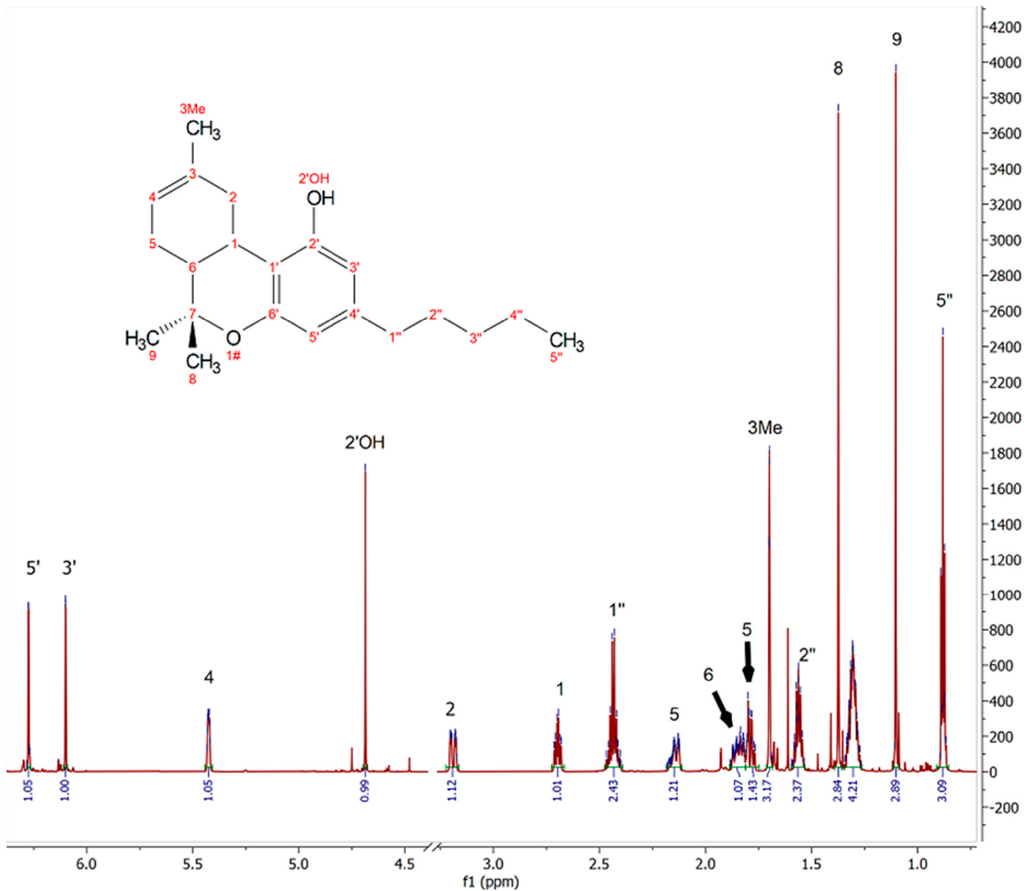
Figure 2. 800 MHz 1 H NMR spectrum of selected sample 3 (empty region from 3.35 ppm to 4.55 ppm omitted) (800 MHz, CDCl 3 ) δ 6.27 (d, J = 1.6 Hz, 1H), 6.10 (d, J = 1.6 Hz, 1H), 5.49 – 5.37 (m, 1H), 4.67 (s, 1H), 3.19 (ddd, J = 17.6, 5.0, 1.9 Hz, 1H), 2.70 (td, J = 10.9, 4.8 Hz, 1H), 2.53 – 2.37 (m, 3H), 2.14 (ddt, J = 15.7, 4.3, 1.7 Hz, 1H), 1.89 – 1.81 (m, 1H), 1.80 – 1.75 (m, 1H), 1.70 (d, J = 1.2 Hz, 2H), 1.58– 1.53 (m, 3H), 1.37 (s, 3H), 1.34 – 1.26 (m, 4H), 1.10 (s, 3H), 0.88 (t, J = 7.0 Hz, 3H).